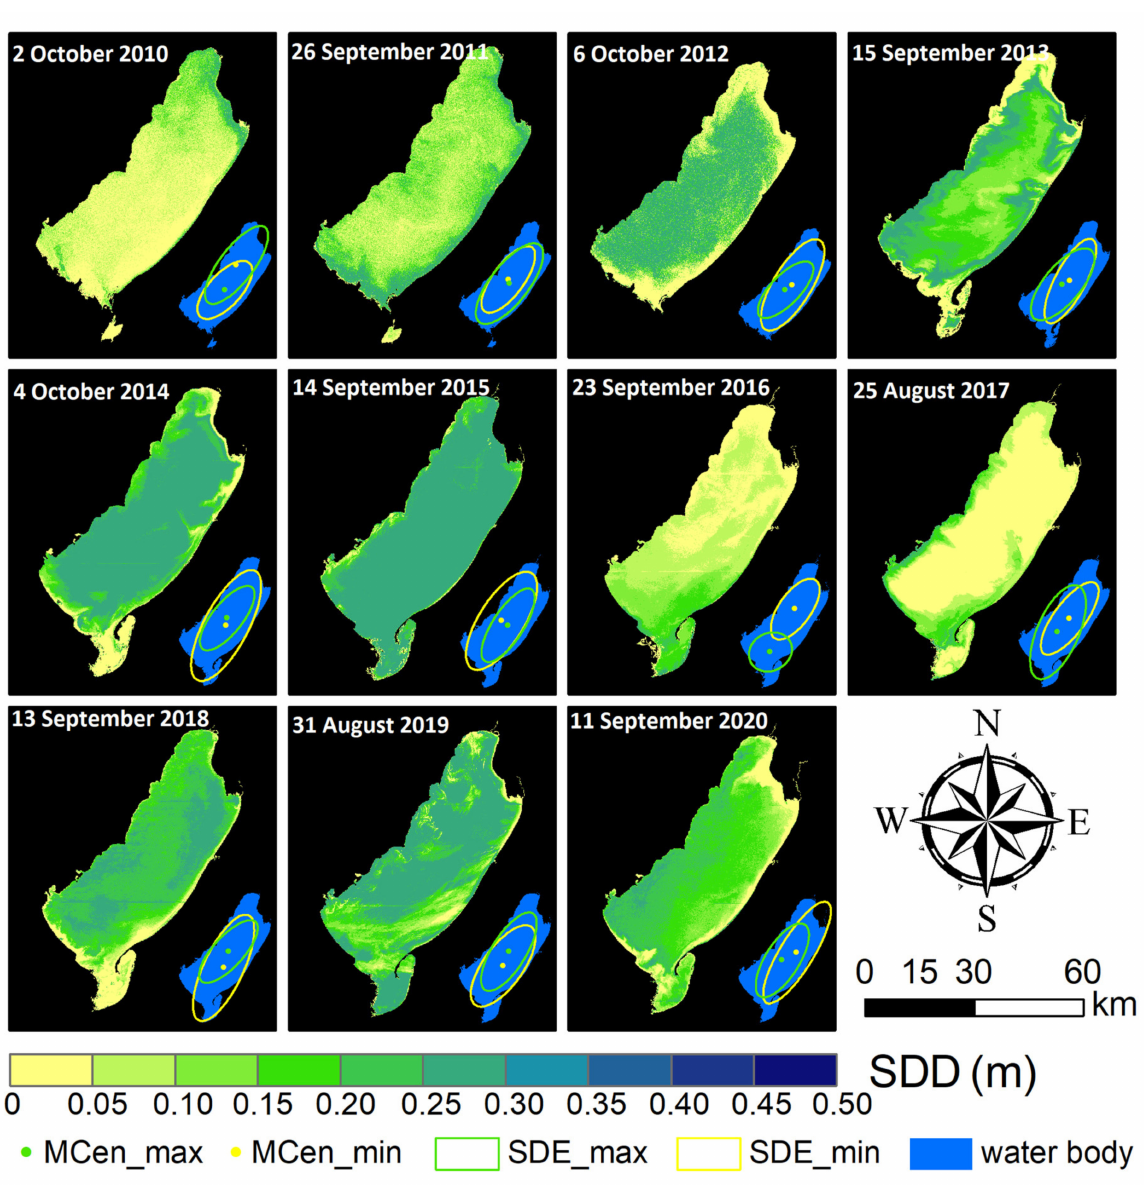
Figure 8. Spatial pattern of autumn transparency in Hulun Lake from 2010 to 2020. The lower right corner is the spatial distribution of the standard deviation ellipse and the mean center of the transparency, the blue background represents the current water body range, the green represents the SDD values (>mean), and the yellow represents the SDD values